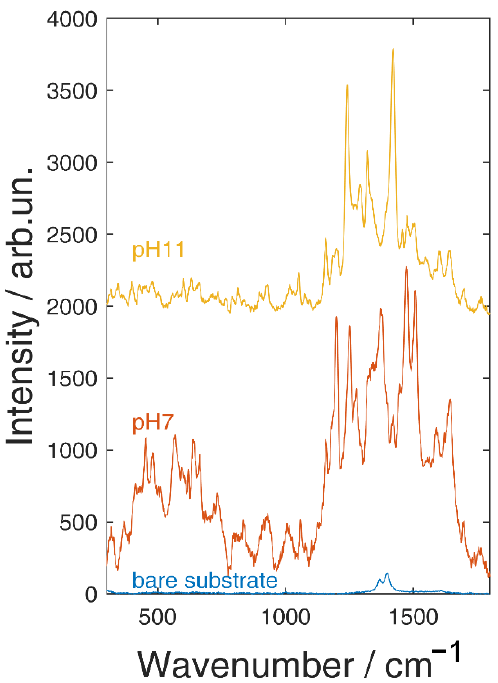
Figure 8. SERS spectra of Alizarine red-S collected by an Ag NPs covered polishing sheets and then diluted by drops of pH 7 and pH 11 solutions .